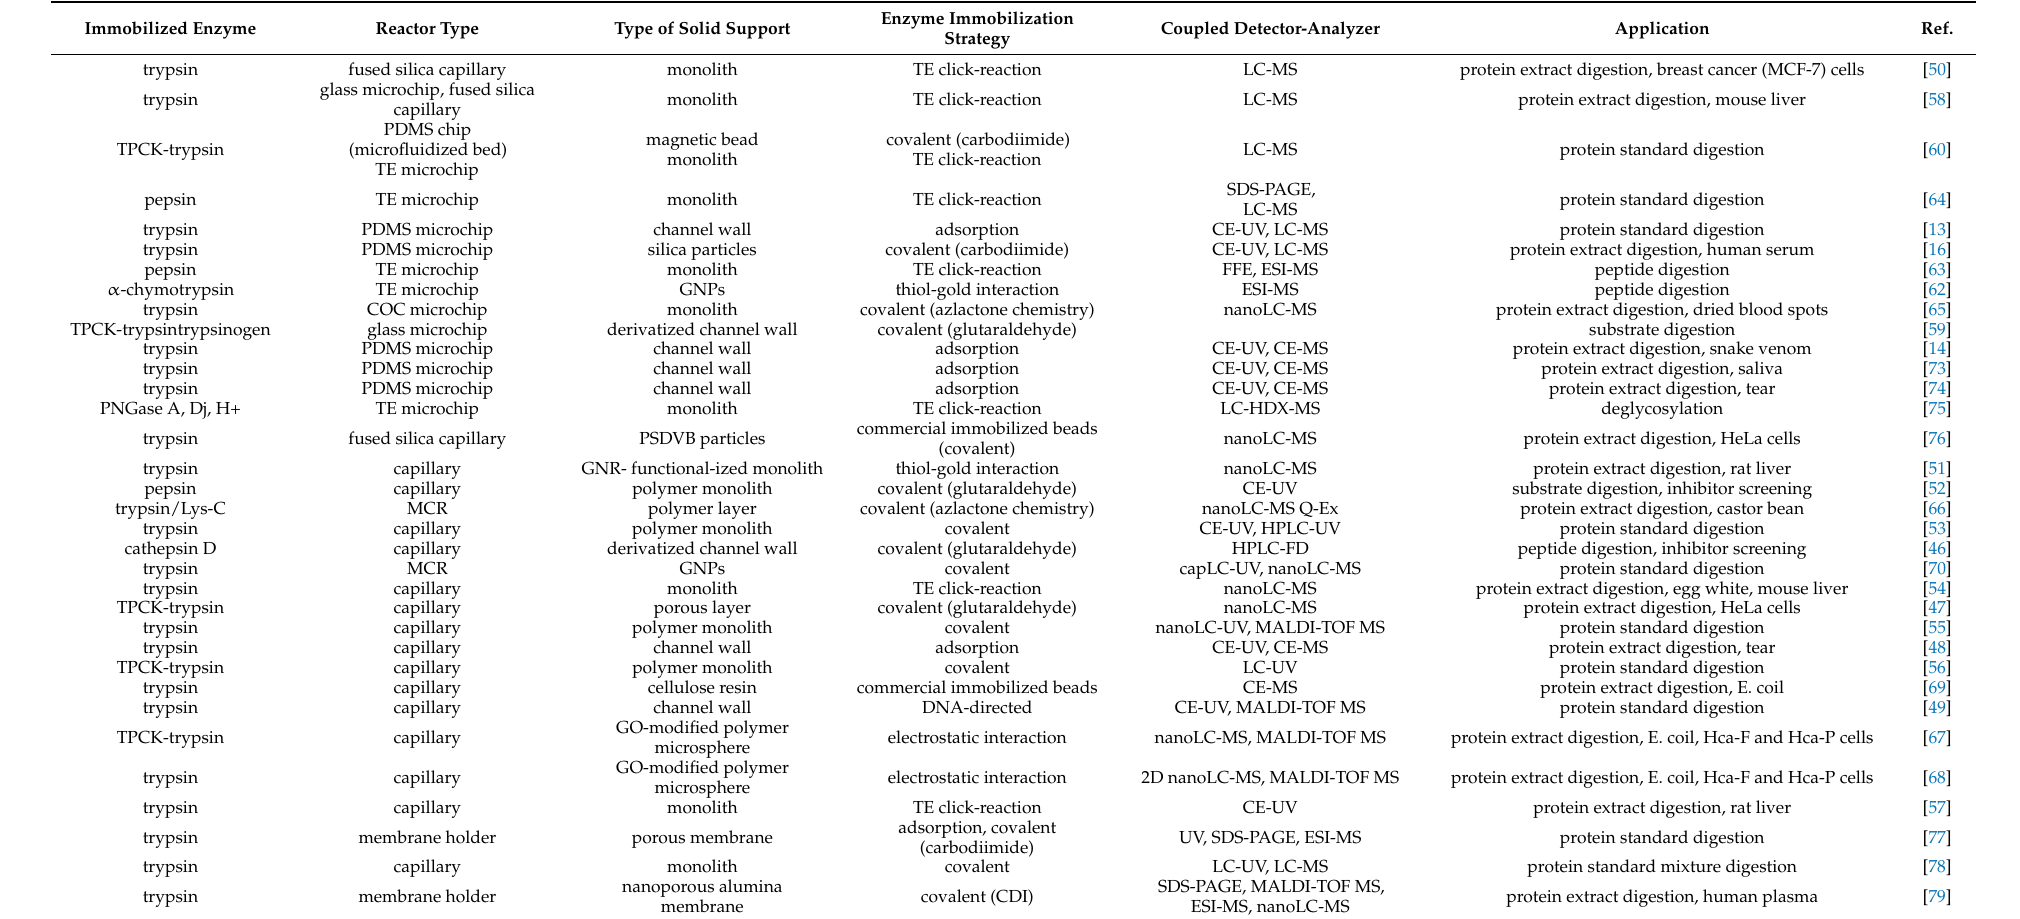
Table 2. Comparison of the µ -IMERs applied for proteomics published between